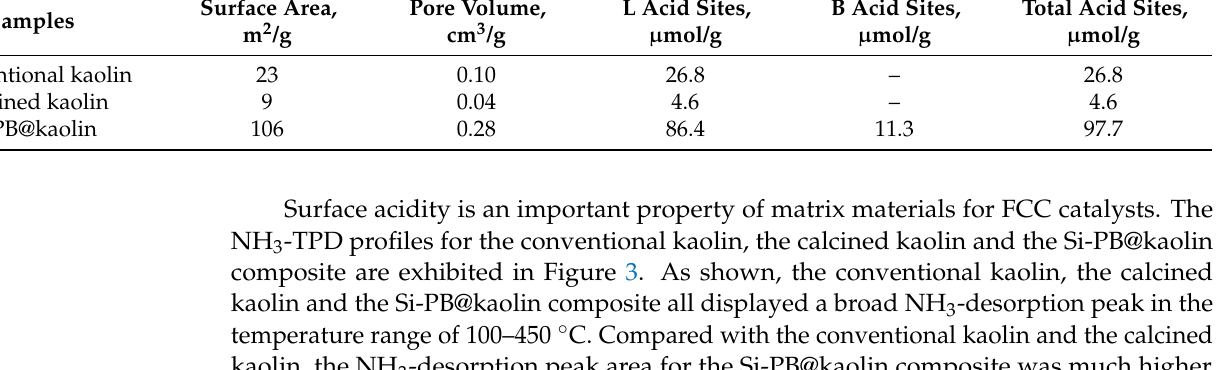
Table 2. Pore structure properties. Acid site quantities for different samples.